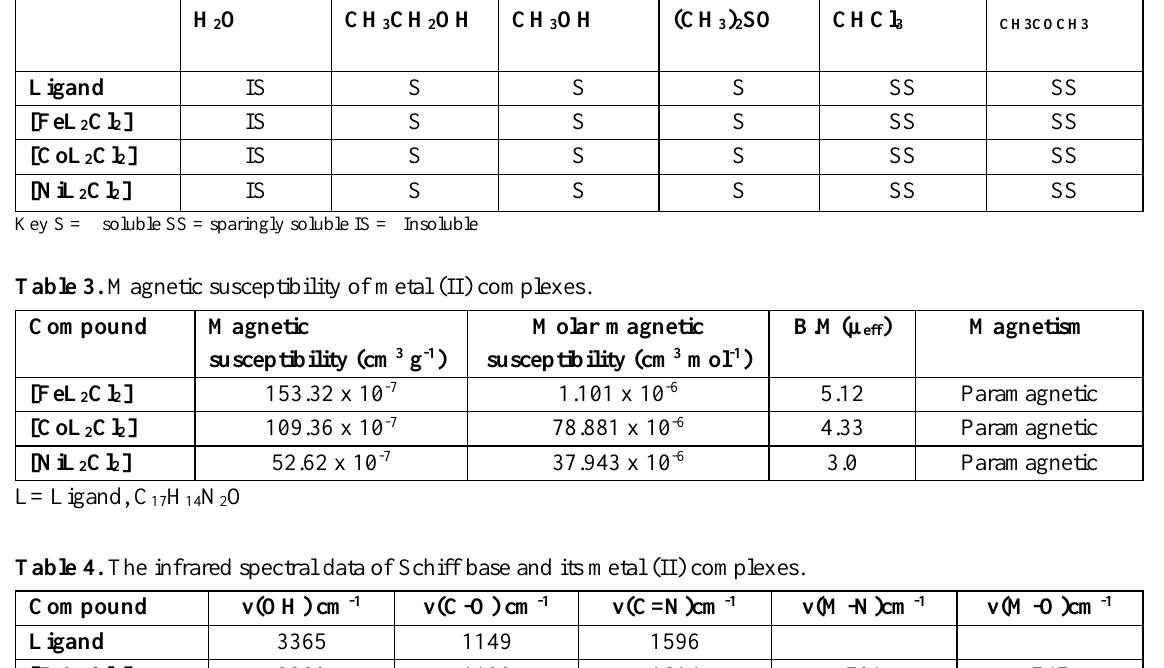
Table 2. Solubility of Schiff base and its metal (II) complexes Compound